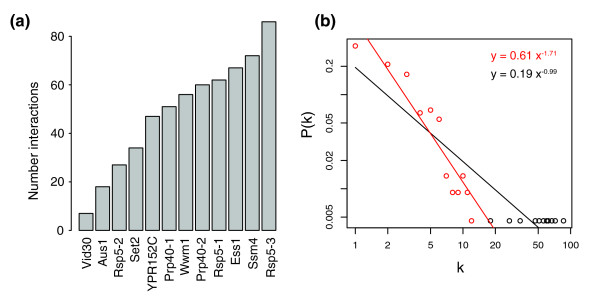
WW domain network properties. (a) The number of interaction partners identified using each WW domain probe. (b) Log-log plot of the node degree distribution within the WW domain network. Black circles represent WW domain probes and red circles represent protein interactors; power law fits to data sets including (black line) and excluding (red line) WW domain probe are shown.